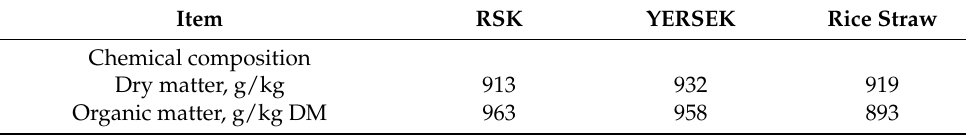
Table 2. Chemical composition of unfermented- and fermented-rubber seed